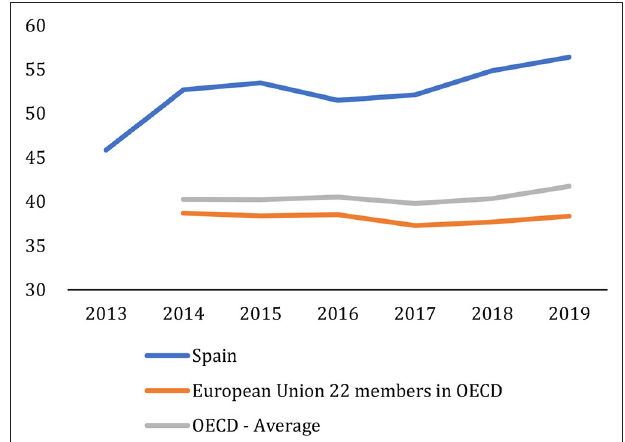
FIGURE 8 | First-time tertiary graduation rates for students below the age of 30. Graduation rates in 2018. Percentage. OECD (2021) and own elaboration.